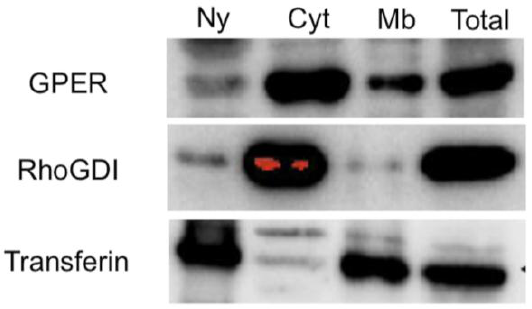
Figure 1. Subcellular fractionation of JKT-1 seminoma-derived cells. Transferin receptor (Transferin) was used as a tag of nuclear (Ny) and membrane (Mb) compartments, whereas RhoGDIα (Rho GDP-dissociation inhibitor) was used as a tag of cytoplasmic (Cyt)